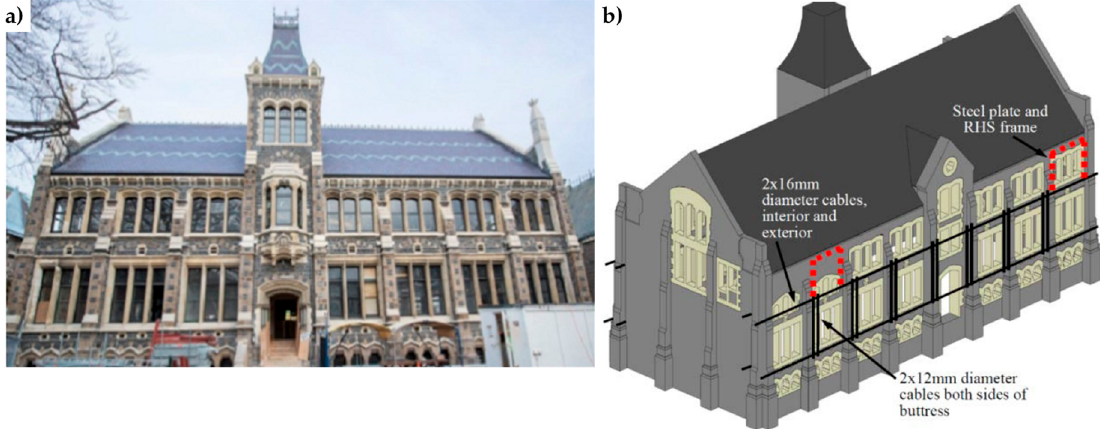
Figure 5. Christchurch Arts Centre, Chemistry building (New Zealand): a ) external overview of the façade; b ) horizontal and vertical cables for external post ‐ tensioning, paired with companion horizontal tendons running parallel on the inside of the wall in order to enhance a frame ‐ type action of building response.